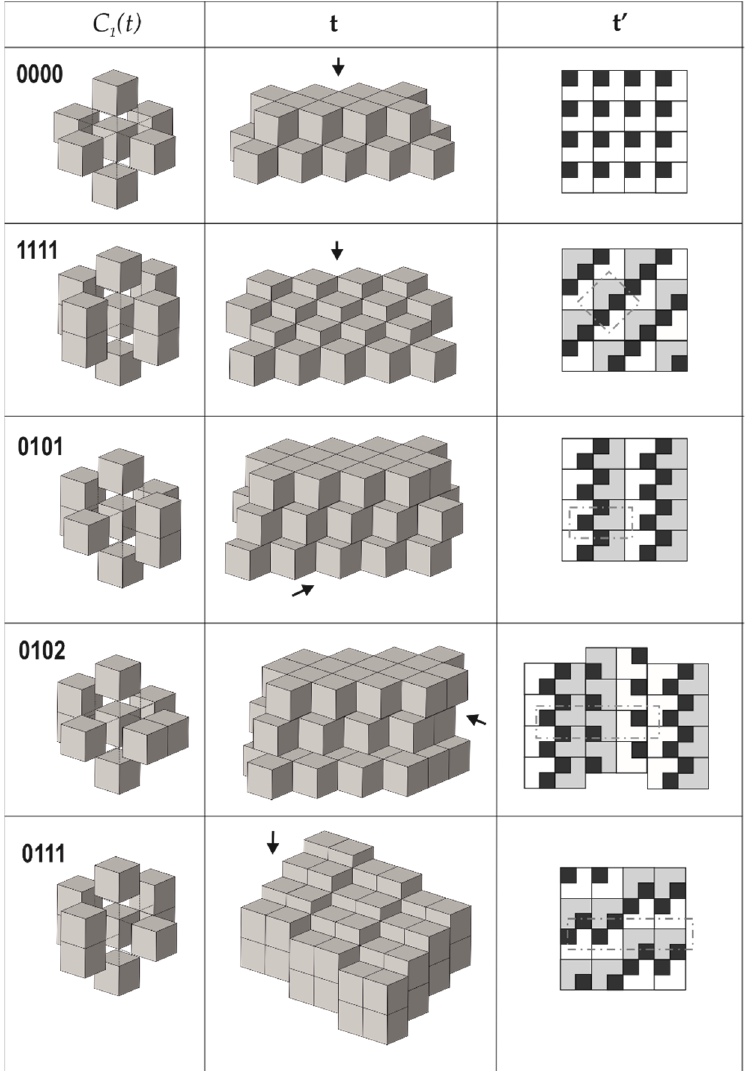
Figure 3. Arrangements of the pseudo ‐ cubic modules in lovozerite ‐ type structures. Legend: C 1 (t) — the arrangement of modules around a central one; t —the general view of the tiling; t’ —the view of the tiling from the direction indicated by the arrow, along with the scheme of arrangement of black cubes (the modules shown in grey are elevated relative to the white modules by 1/2 a , where a is the edge length of the module); dot ‐ and ‐ dash lines outline the unit cell contours. Modified after [70].